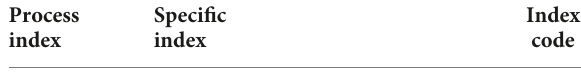
TABLE 2 Information technology (IT) governance evaluation